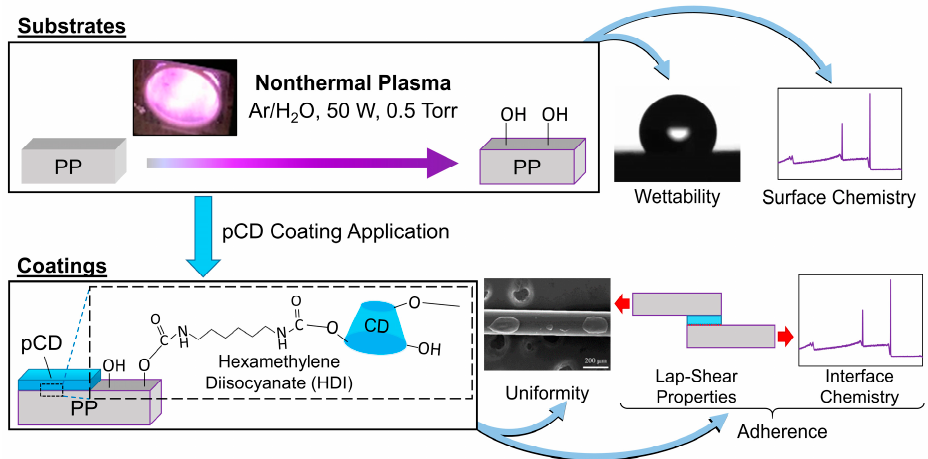
Figure 1. Study overview. Effects of nonthermal plasma on polypropylene (PP) substrates were investigated in terms of wettability and surface chemistry, and effects on polymerized CD (pCD) coatings were explored in terms of uniformity and adherence.